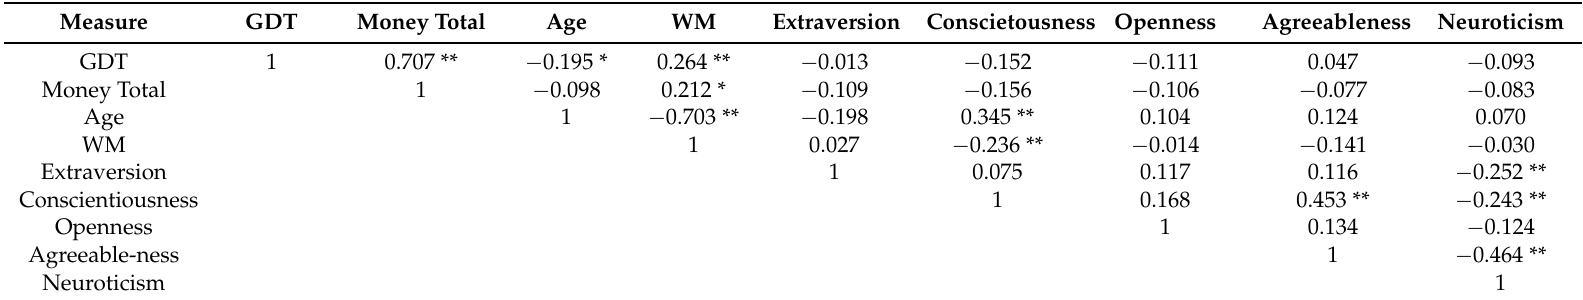
Table 3. Correlations between GDT, money total, age, working memory, and personality.